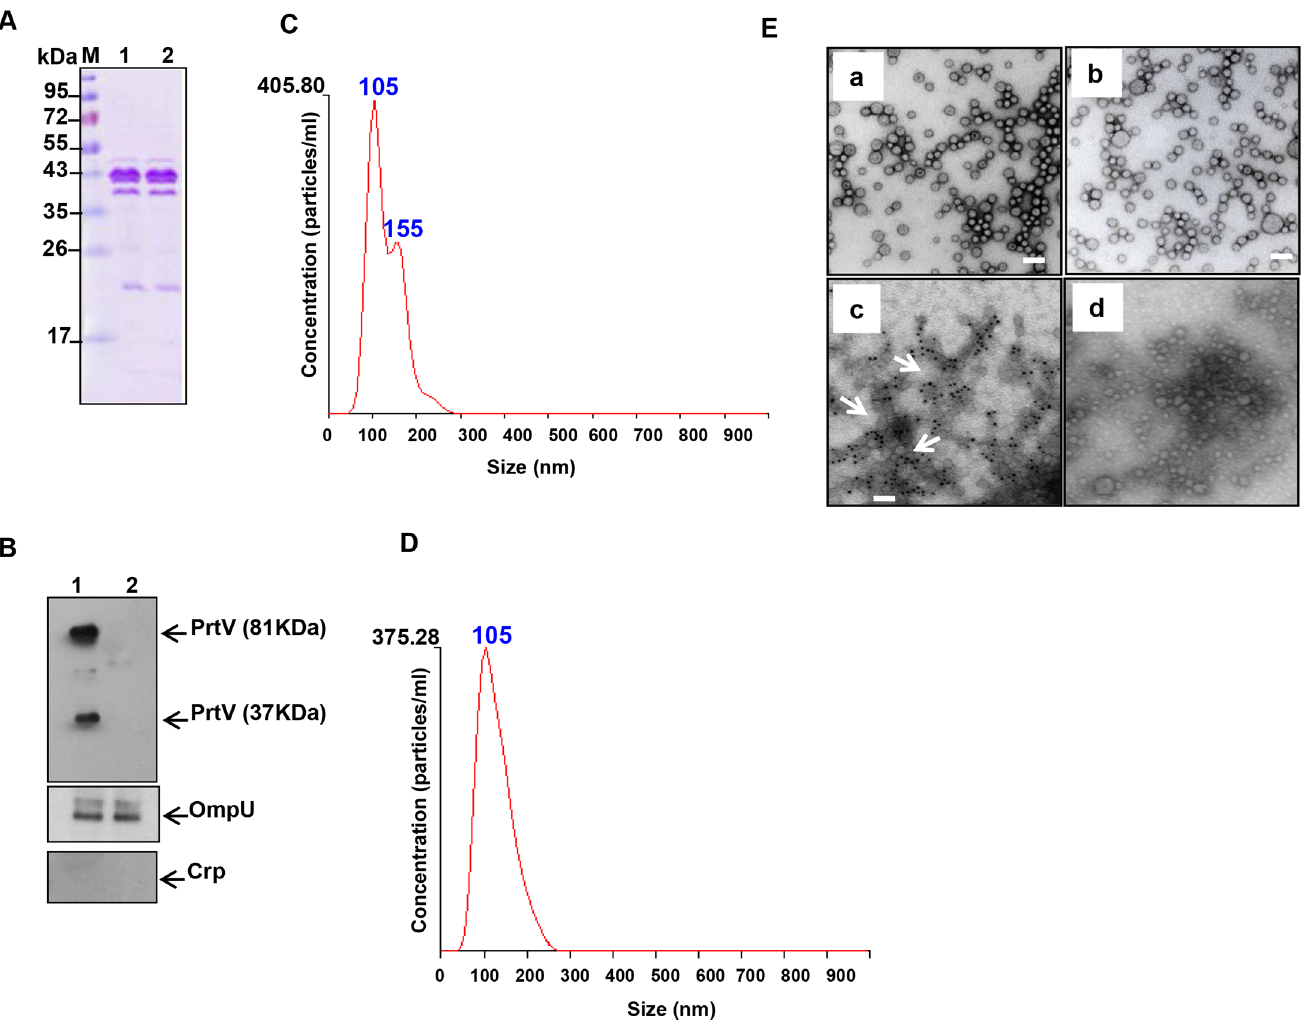
Fig 3. SDS-PAGE, immunoblot analyses, Nanoparticle tracking analysis and electron microscopic analyses of OMV samples from the wild type strain C6706 and the prtV mutant. (A) SDS-PAGE and Coomassie blue staining of OMVs samples from V . cholerae wild type C6706 (lane 1) and its derivative prtV mutant (lane 2). (B) Immunoblot analysis of PrtV protein in the OMV samples from the wild type strain C6706 (upper panel, lane 1) and the prtV mutant (upper panel, lane 2) using anti-PrtV polyclonal antiserum. Immunoblot analysis of OMV samples using anti-OmpU antiserum as a OMV marker (middle panel) and anti-Crp polyclonal antiserum as a cytoplasmic protein marker (lower panel). (C) Nanoparticle tracking analysis measurement of OMVs isolated from the wild type V . cholerae strain C6706 showing the sizes and total concentration of OMVs. (D) Nanoparticle tracking analysis measurement of OMVs isolated from the Δ prtV mutant showing the sizes and total concentration of OMVs. (E) Electron microscopy of OMVs from the wild type V . cholerae strain C6706 (a) and the prtV mutant (b). Immunogold labeling of OMVs from V . cholerae wild type strain C6706 (c) and the prtV mutant (d). White arrow points to gold particles associated with OMVs. Bars; 150